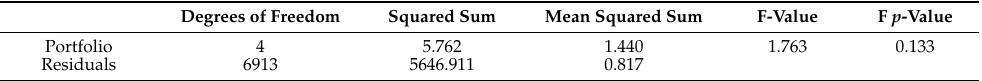
Table 7. One-way ANOVA test of the simulated portfolios’ ex-post